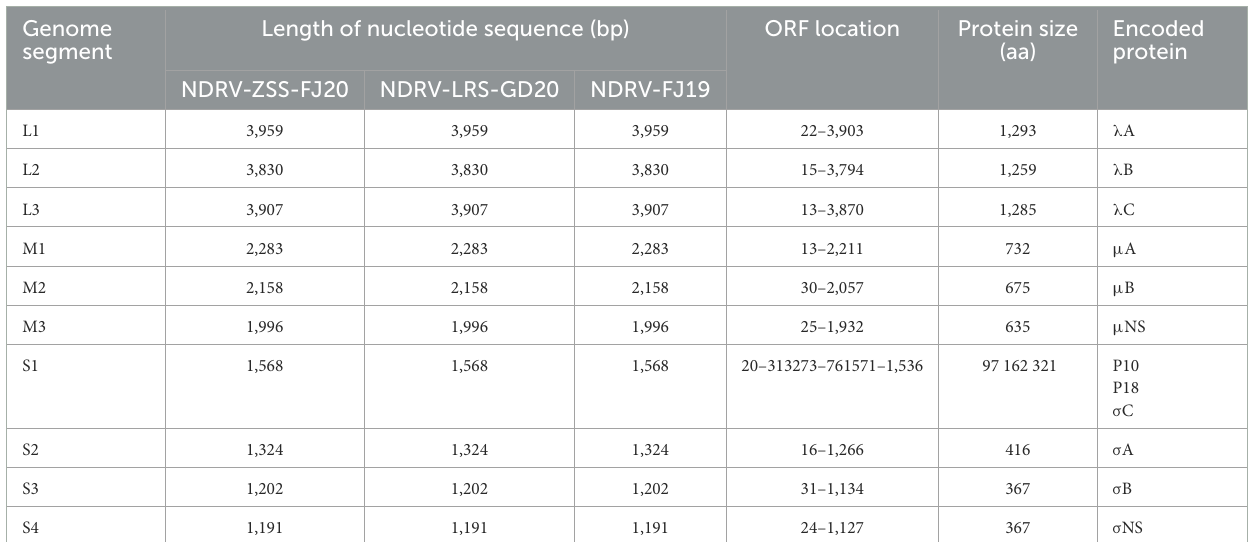
TABLE 3 General genome features of the three novel duck reovirus